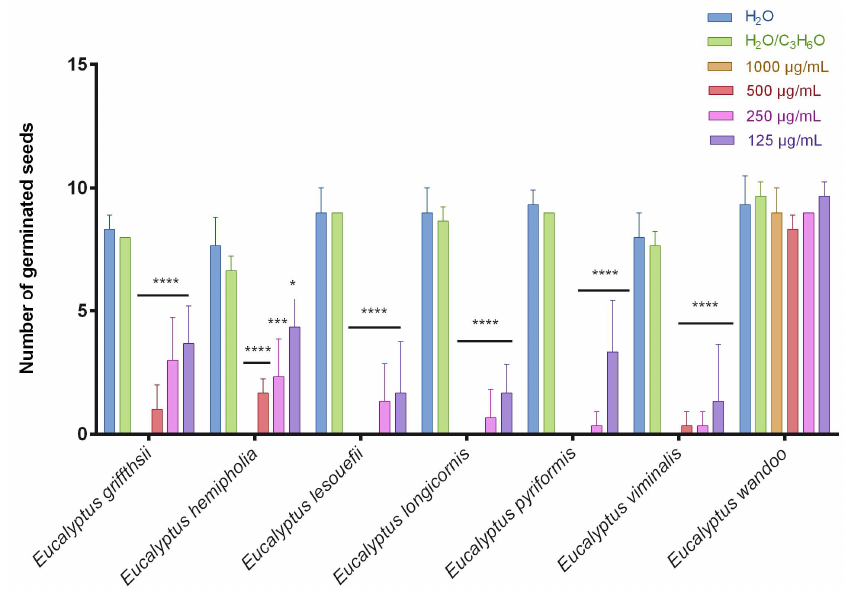
Figure 3. Number of germinated seeds of Raphanus sativus seeds after treatment with different concentrations (125–1000 µg/mL) of Eucalyptus essential oils measured 120 h after sowing. Results are the mean ± standard deviation ( n = 3) of three independent experiments. * p < 0.05; *** p < 0.001, **** p < 0.0001 compared to control (ANOVA followed by Dunnett’s multiple comparison test).